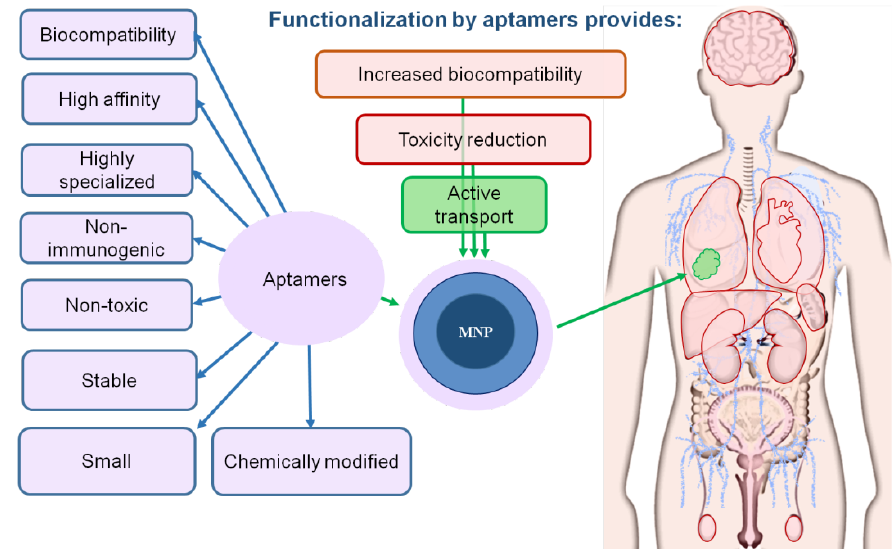
Figure 5. Aptamers increase the biocompatibility of magnetic nanoparticles. The magnetic core of the nanoparticle is shown in dark blue; the shell is represented in light blue; aptamer coating is light violet. The tumor is depicted in green.